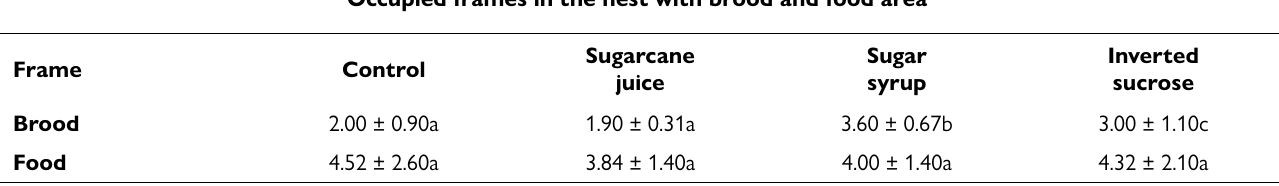
Table 3. Mean and standard deviation of the number of brood and food frames from control, sugarcane juice, sugar syrup and inverted sucrose treatments, throughout the experimental period. Occupied frames in the nest with brood and food area